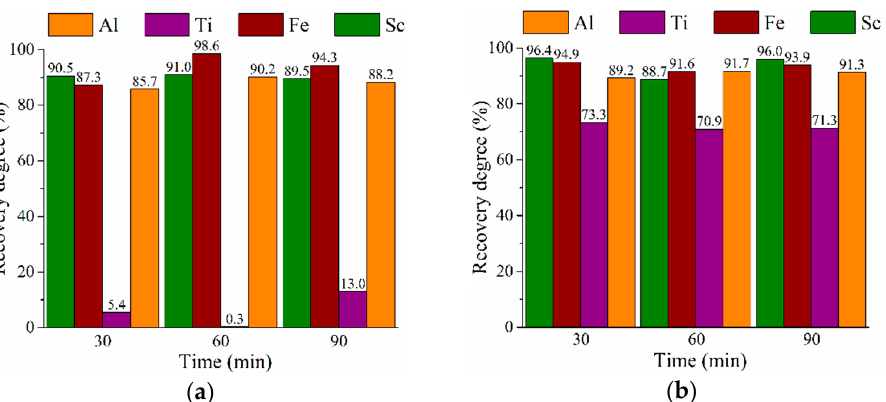
Figure 12. Effect of leaching time on the recovery degree of Al, Ti, Fe, Sc at 150 °C and S:L = 1:11 using 10% ( a ) and 20% ( b ) HCl.